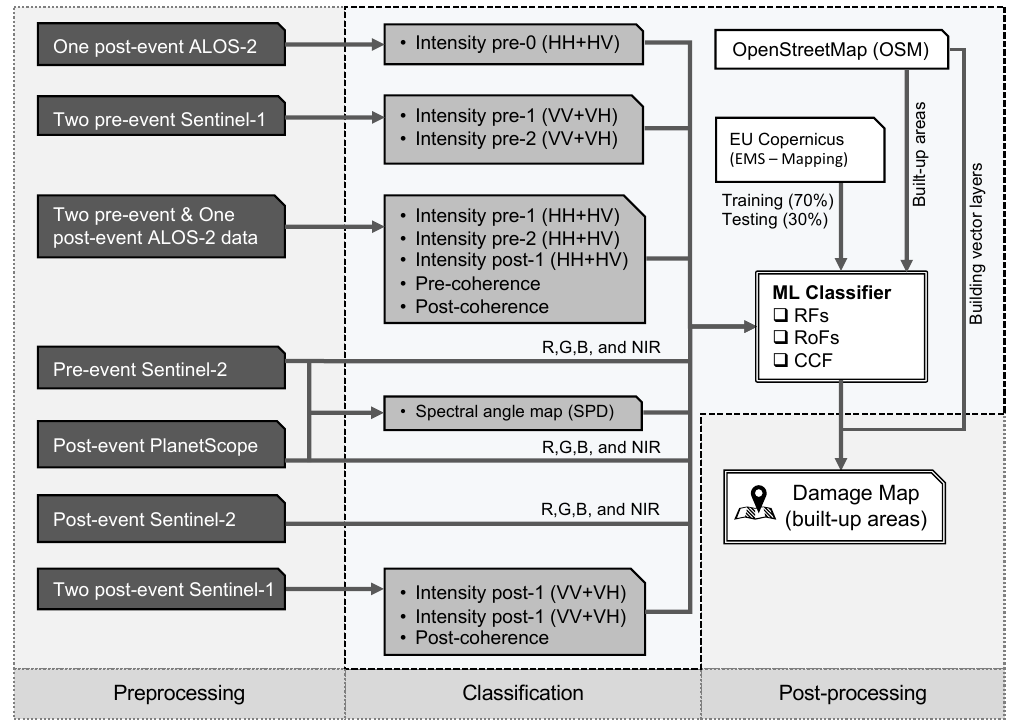
Figure 3. Research workflow for building damage mapping using multi-source and multi-temporal remote sensing